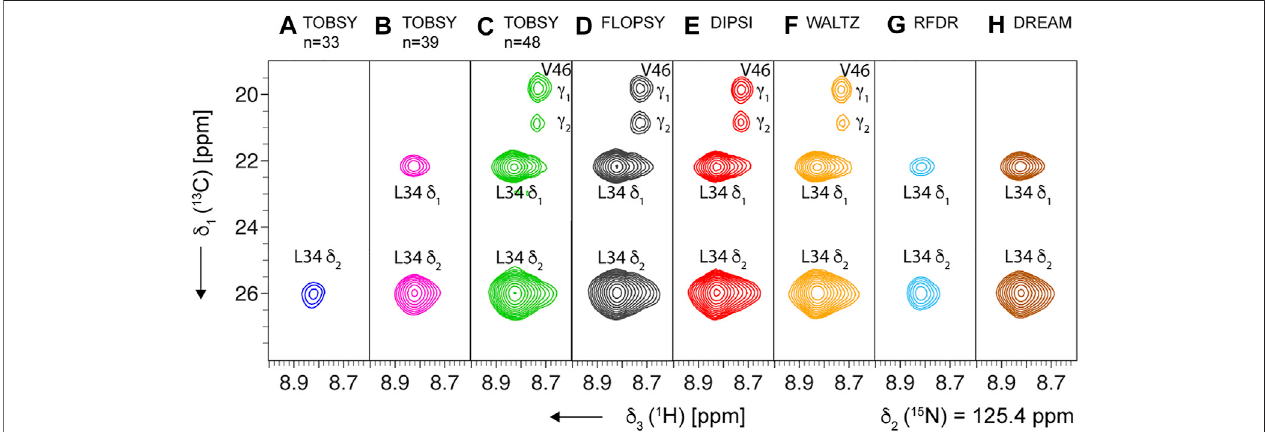
FIGURE 8 | Representative strips from 3D (H)C(CC)(CA)NH experiment for SH3 protein recorded at MAS frequency of 94.5 kHz and on an 18.8-T spectrometer, using the following mixingschemesat their optimal mixingtime (see Supplementary Table S3 ): (A – C) TOBSYC9 1 n , with n =33, 39,and 48, respectively, (D) FLOPSY- 16, (E) DIPSI-3, (F) WALTZ-16, (G) RFDR ( ν 1 = 100 kHz), and (H) DREAM. All planes show the cross-section at δ 2 ( 15 N) = 125.4 ppm, and show two cross-peaks for Leu-34 residue (L34 1 H N , 15 N intra-residue correlations to δ 1 and δ 2 13 C). The most intense spectra (panels C – F ) additionally show cross-peaks of Val-46 residue due to partial overlap of L34 and V46 1 H N and 15 N frequencies.